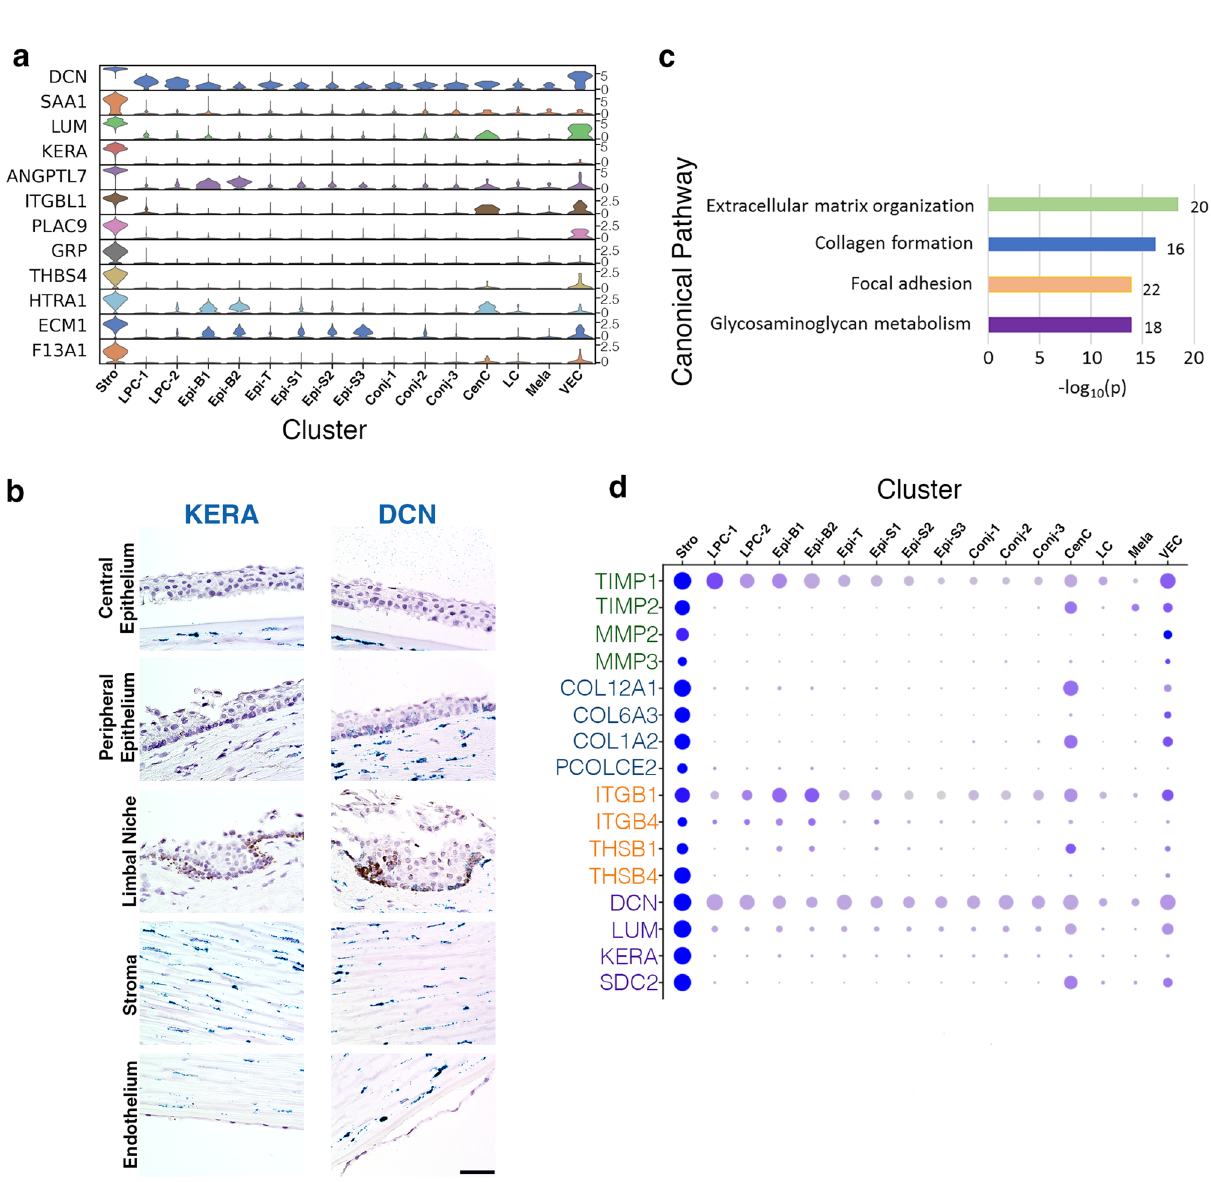
suggests that LPC-1 enriched genes can also be expressed in a few clusters which reside in the basal epithelium of the peripheral cornea. Therefore, LPC-1 was chosen as the origin point of the other corneal epithelial cell clusters in our PAGA and pseudotime analyses (Fig. 4c–e).